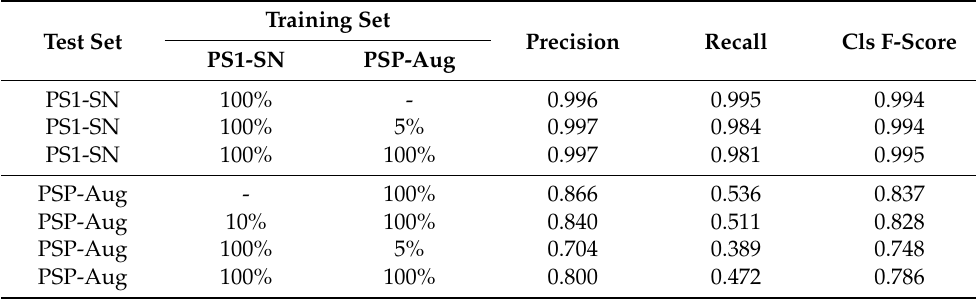
Table 5. Performance of FCOS on the hybrid datasets with different blending ratios. Test